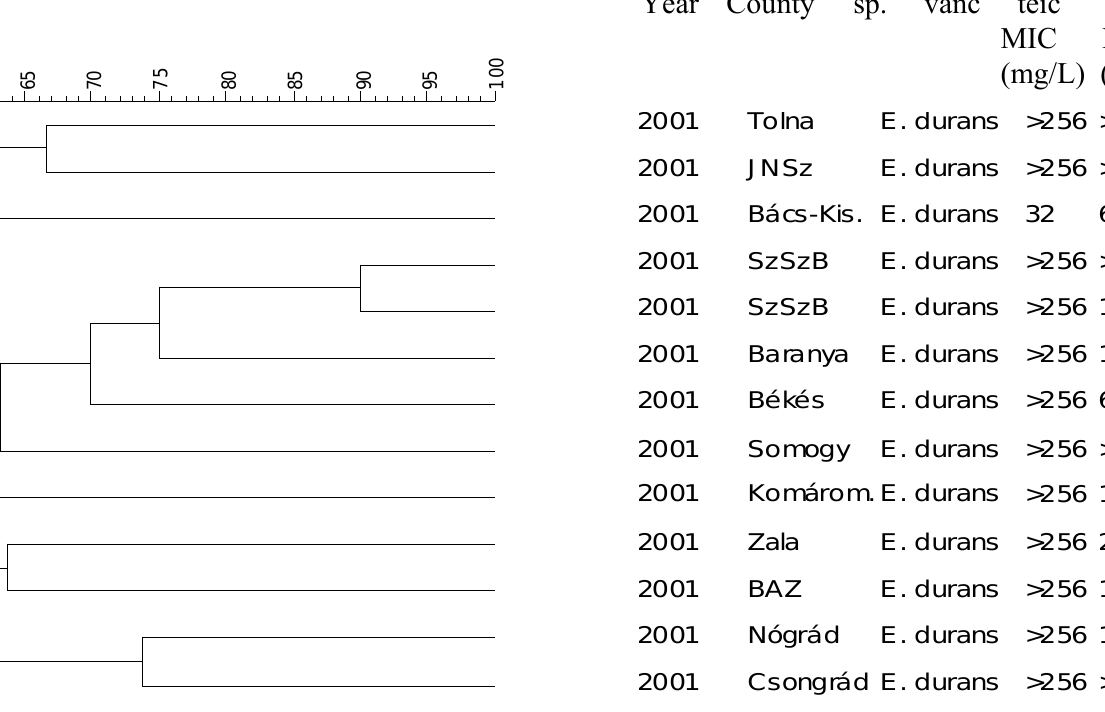
Figure 18. Dendrogram of vancomycin-resistant E. durans strains isolated from chicken in 2001